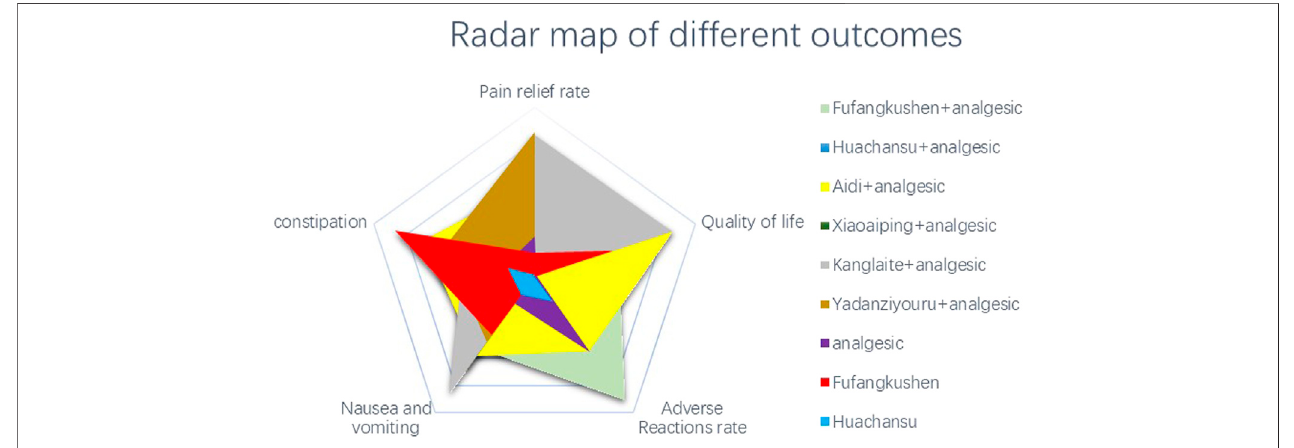
FIGURE 5 | Radar map of different outcomes. Note: the outstanding interventions appear on the outermost side of the corresponding line in the radar map.